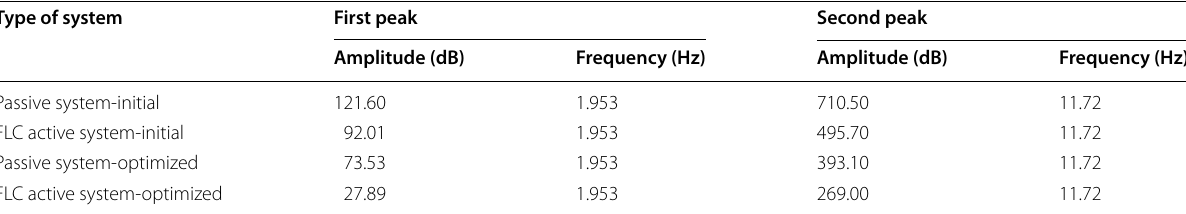
Table 3 Frequency response results—passive and FLC suspension